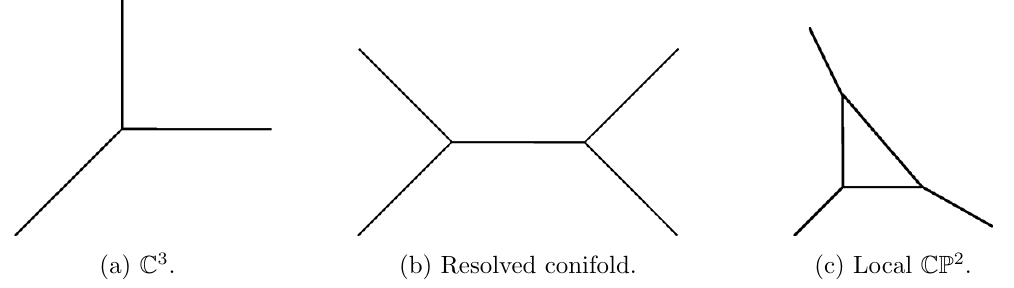
Figure 15. Toric diagrams of some local Calabi-Yaus.